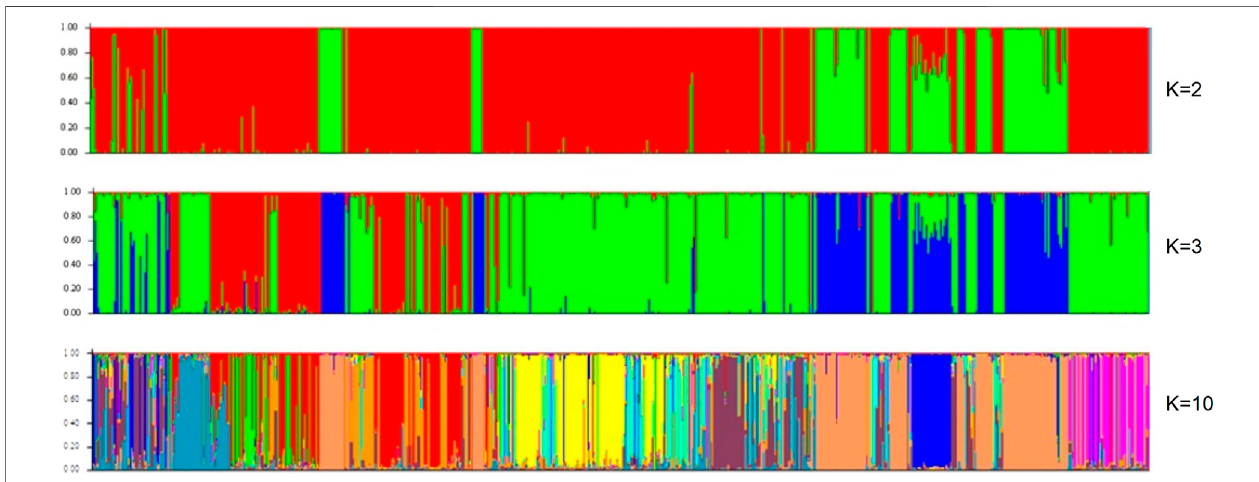
FIGURE 1 | Populations of Curraleiro Pé-Duro cattle detected by the method of clusters with genetic similarity using breed characterization markers.